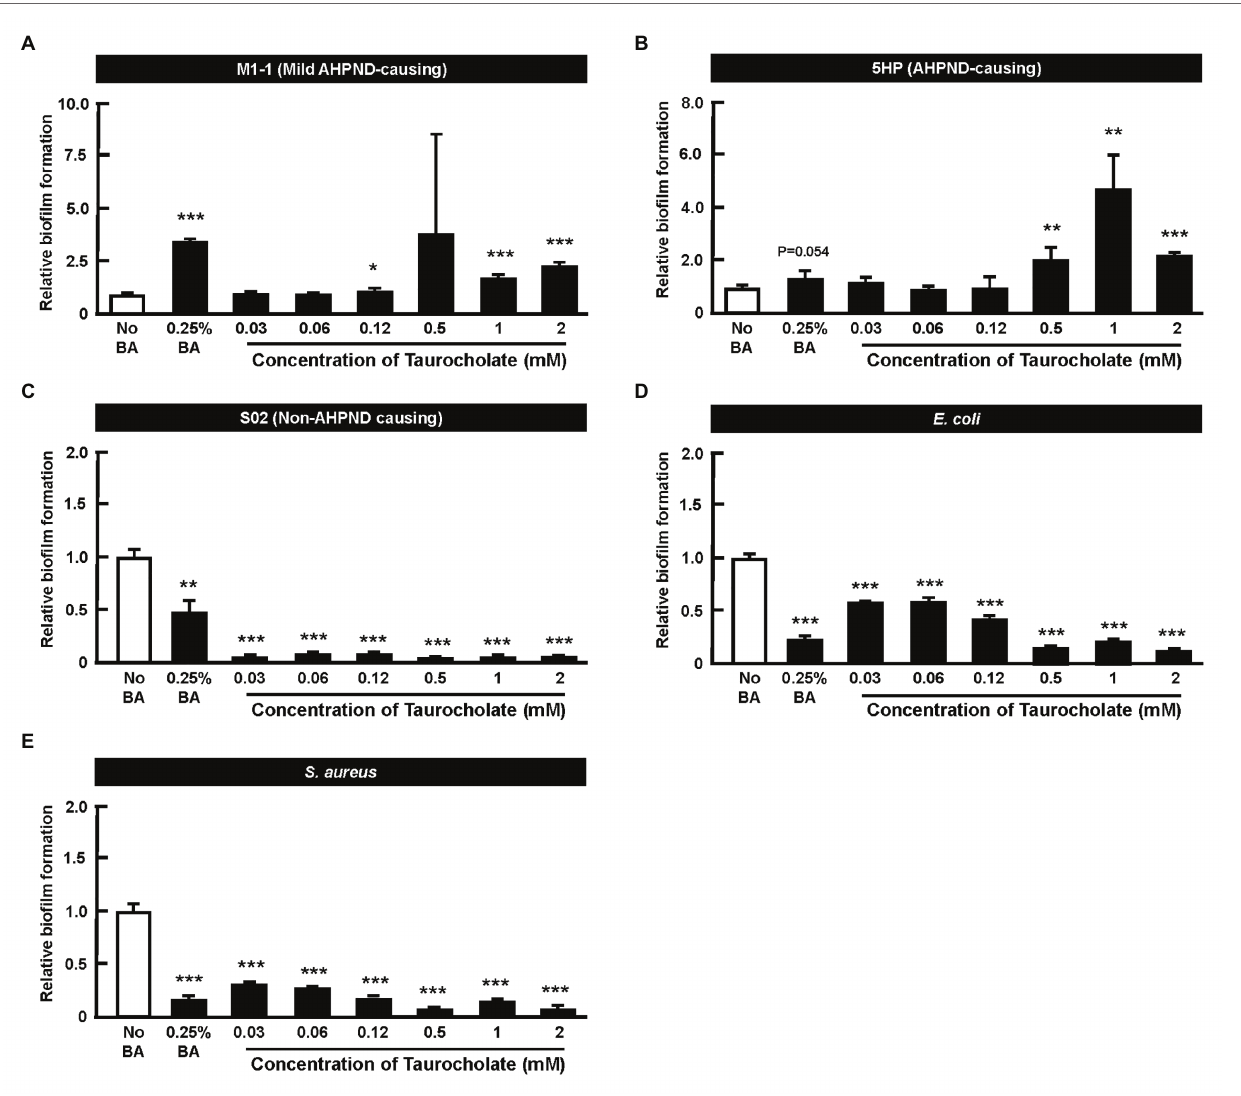
FIGURE 6 | Taurocholate induced biofilm formation in AHPND-causing Vibrio parahaemolyticus . Biofilm assays were conducted at various concentrations of taurocholate for (A) M1-1, (B) 5HP, (C) S02, (D) Escherichia coli , and (E) Staphylococcus aureus in 96-well plates. The biofilms were stained with crystal violet stain and quantified at OD 550 nm. The data represent fold change compared to no-bile-acid control. Each bar represents mean ± SD. The statistically significant differences between treatment and control groups are indicated as asterisks (Student’s t -test, * p < 0.05, ** p < 0.01, and *** p <